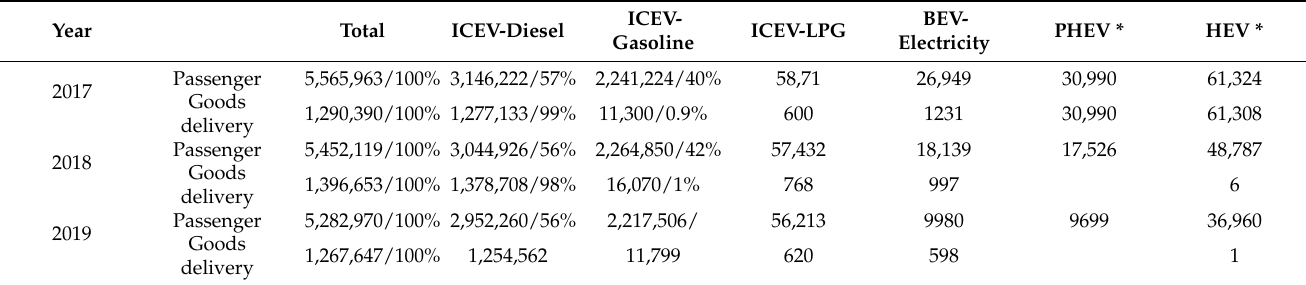
Table 1. Light-duty circulating fleet composition by technology/fuel in 2017–2018–2019. ICEV— Internal Combustion Engine Vehicle, BEV—Battery Electric Vehicle, PHEV—Plug-in Hybrid Electric Vehicle, HEV—Hybrid Electric